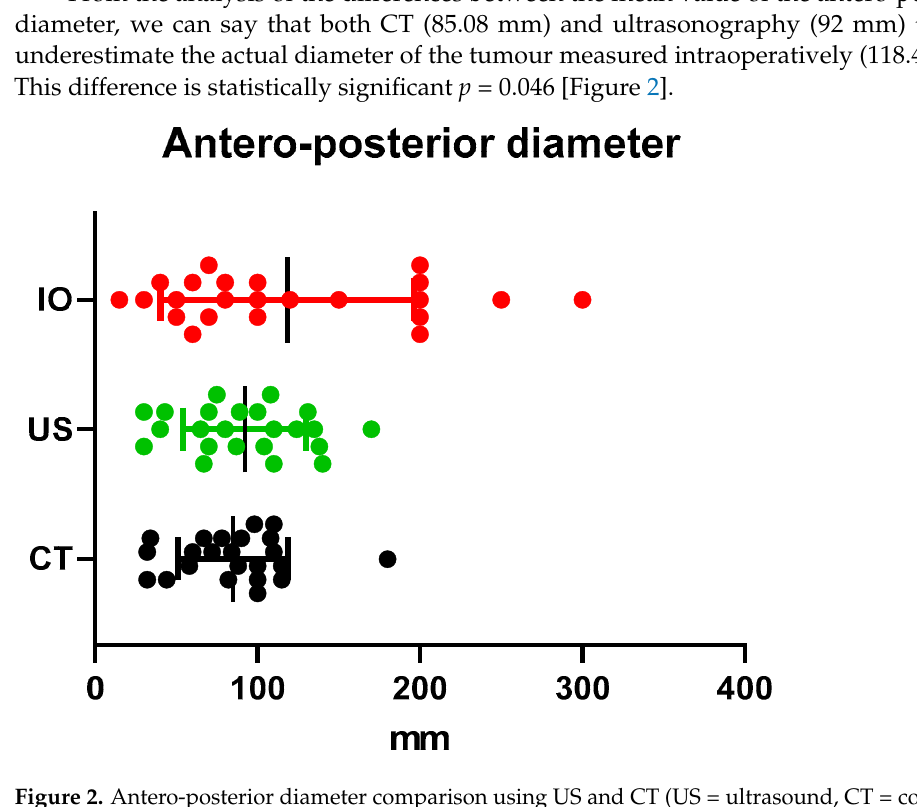
Figure 2. Antero-posterior diameter comparison using US and CT (US = ultrasound, CT = computed tomography, IO = intraoperatively).